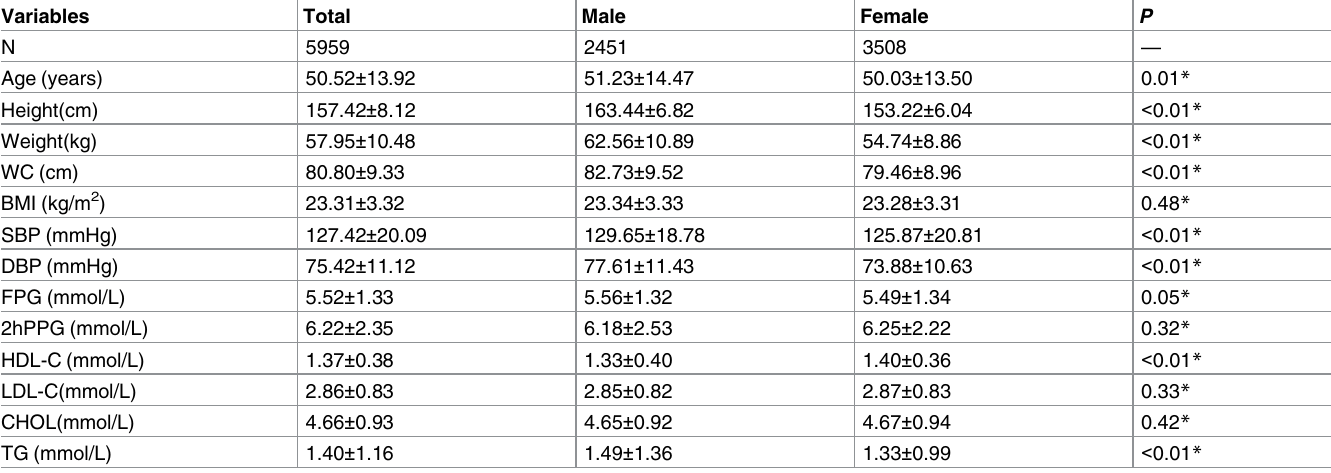
Table 2. Characteristics of the